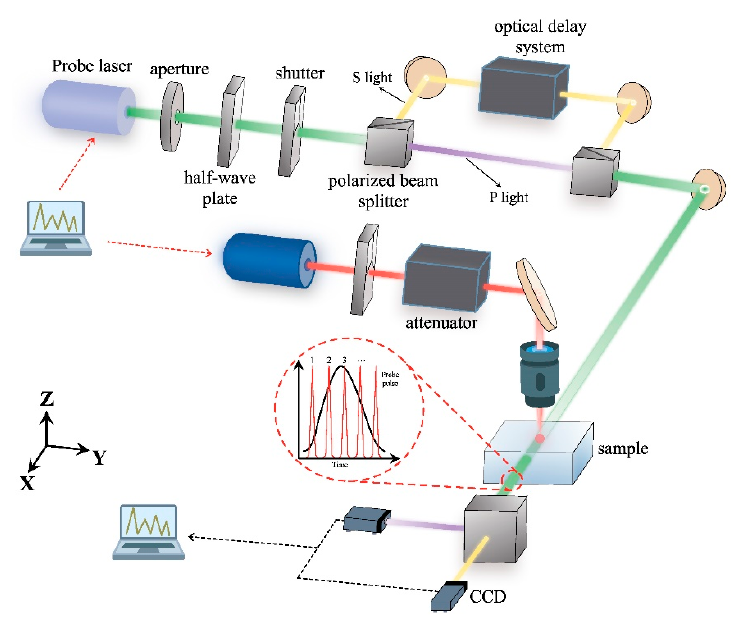
Figure 8. Schematic diagram of time Resolved Pump and Probe (TRPP) technology [69].